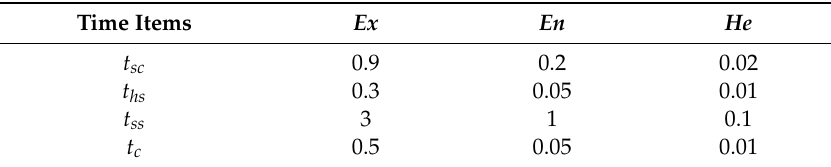
Table 3. Parameters of the cloud